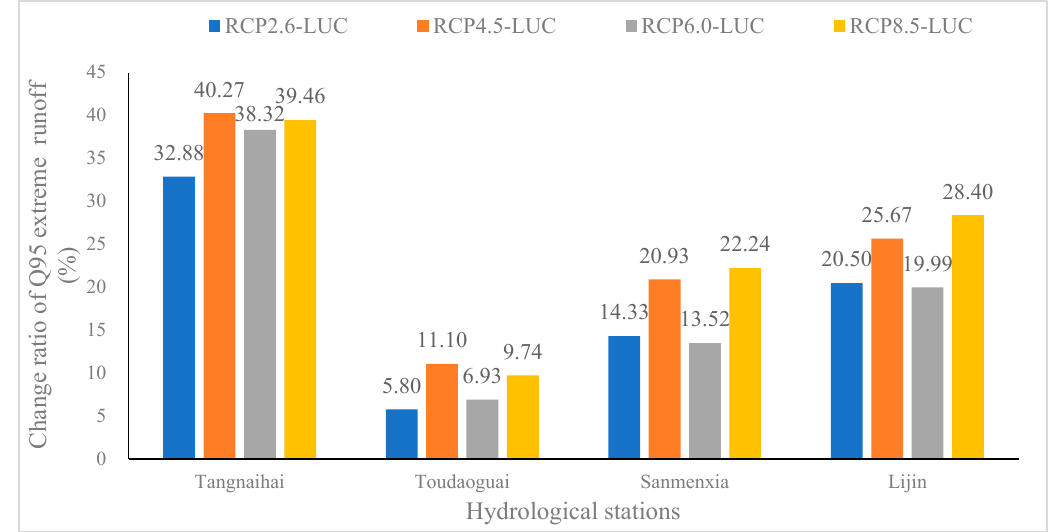
Figure 13. The differences between the Q95 extreme runoff in the future period and the base period of the four hydrological stations.